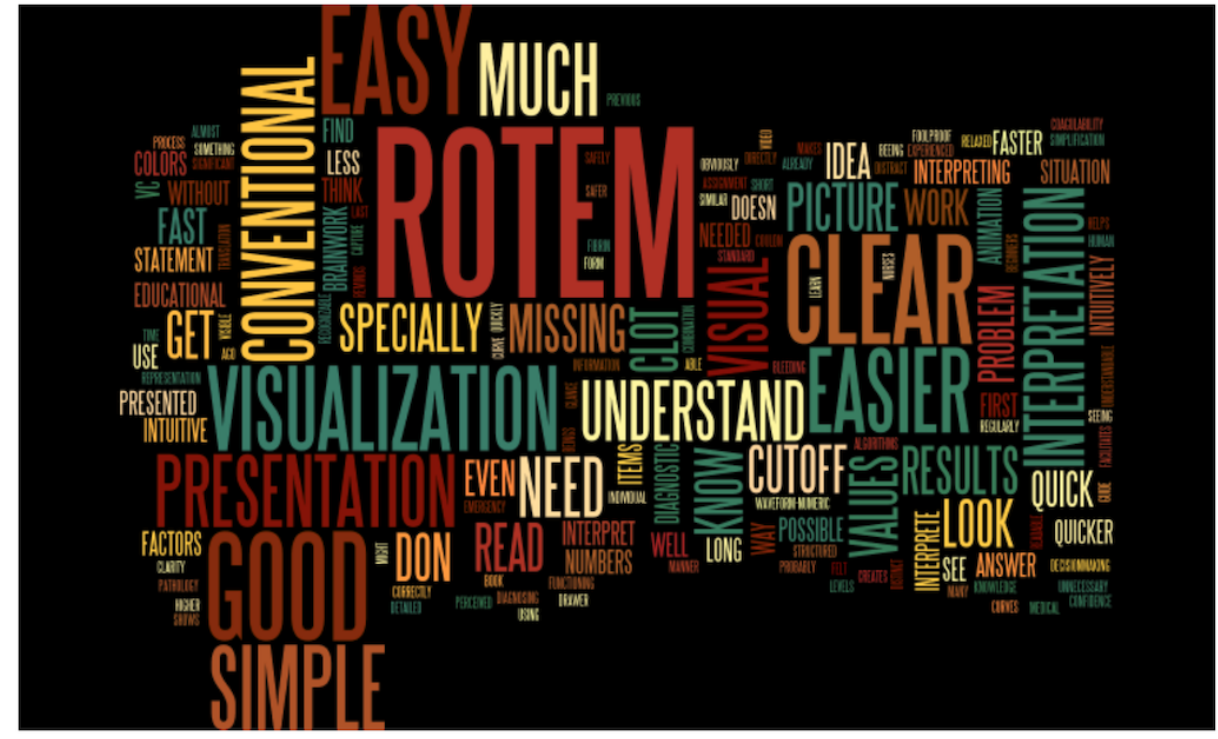
Figure 2. A tag cloud as a quantitative graphic illustration of the most common words in the interview field notes. This word cloud was created using Wordle.net. Common English words (the, and, to, etc) are not displayed. Frequently occurring terms have larger font sizes.